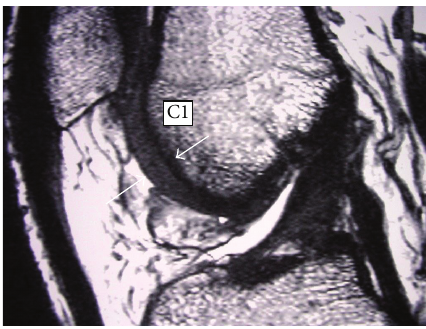
Figure 3: Mapping of MRI showing region that is C1. White arrowsshowcartilagethicknessintrochlearregionoflateralanterior femoral